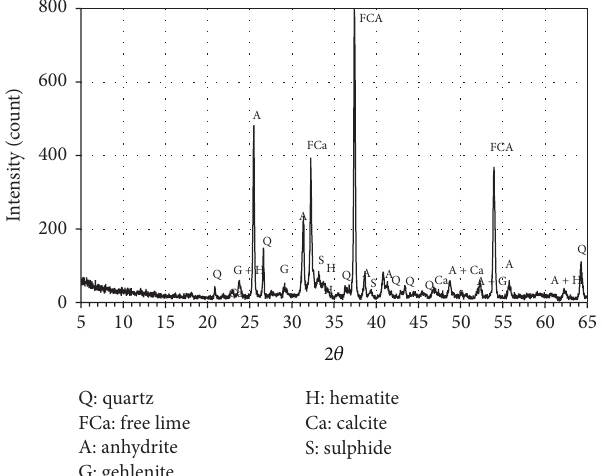
Figure 6: The X-ray diffractogram of YFA.